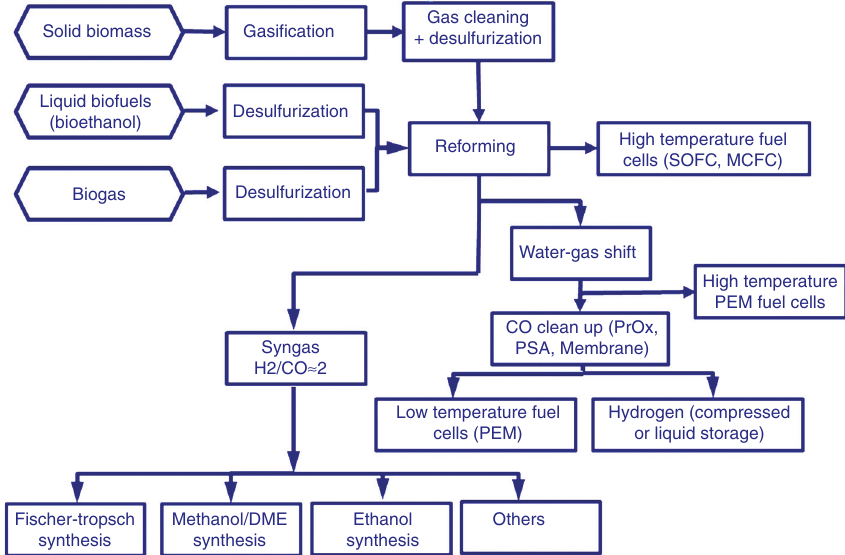
Figure 2 Renewable routes for energy and fuel production based on chemical synthesis routes.